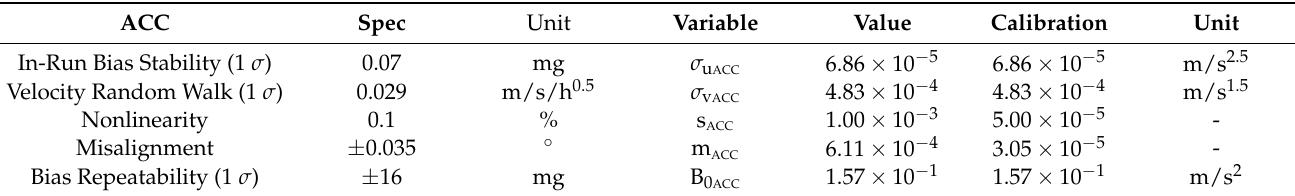
Table 15. Example for accelerometers’ performance values.